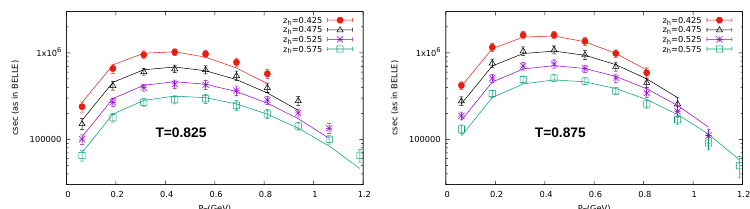
Figure 5: Cross section as a function of P (left panel) and T = 0.825 (right panel), corresponding to a restricted selection of z -bins, 0.4 < z <